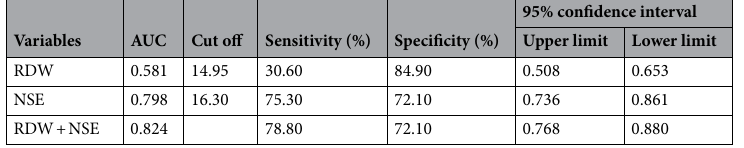
Table 2. Diagnostic values of RDW alone and NSE alone, and combined detecting in differential diagnosis between NSCLC and SCLC.